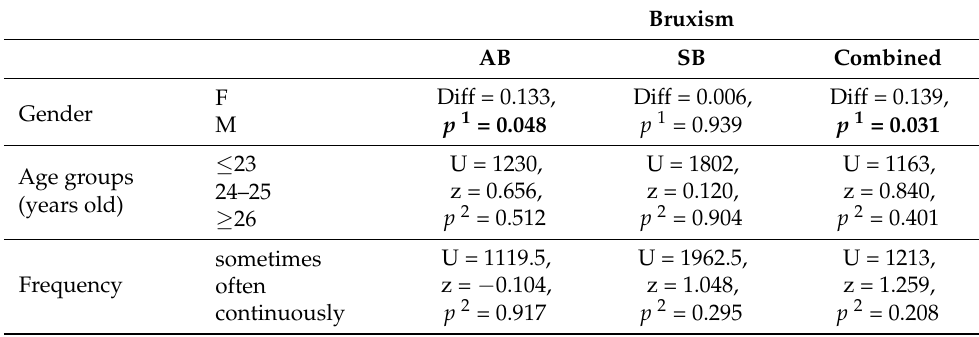
Table 1. Statistical results following group distribution analysis by gender, age, frequency of bruxism episodes, and the presence of SB, AB, and combined bruxism.